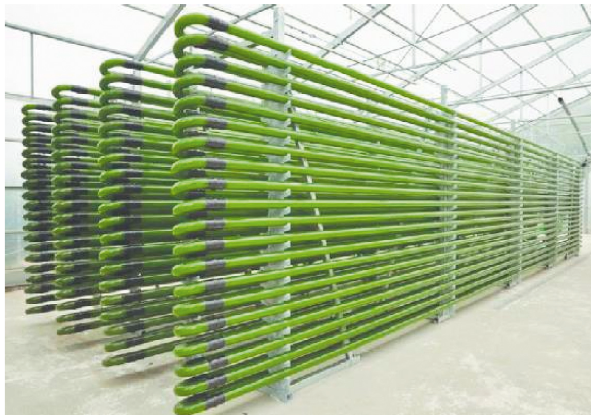
Figure 2: Photobioreactor